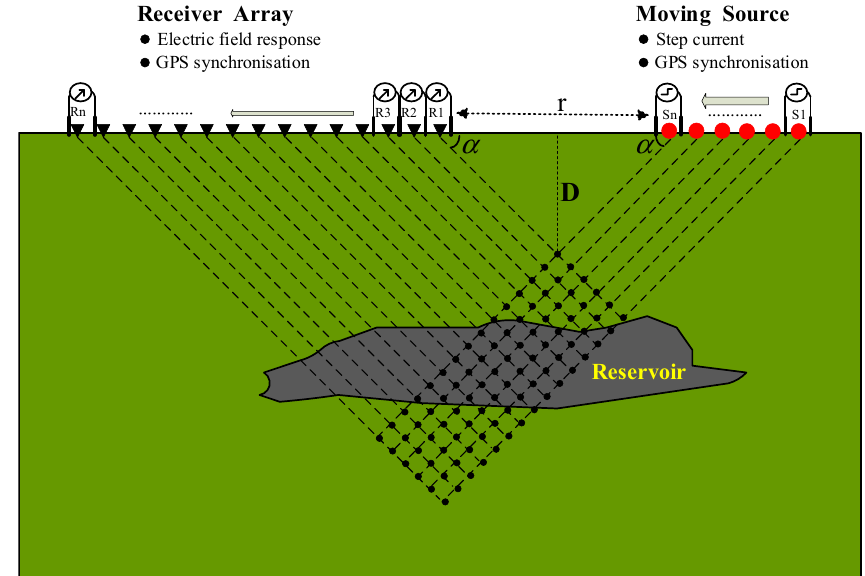
Fig. 1 Field observation model and the MCSEM geometry imaging